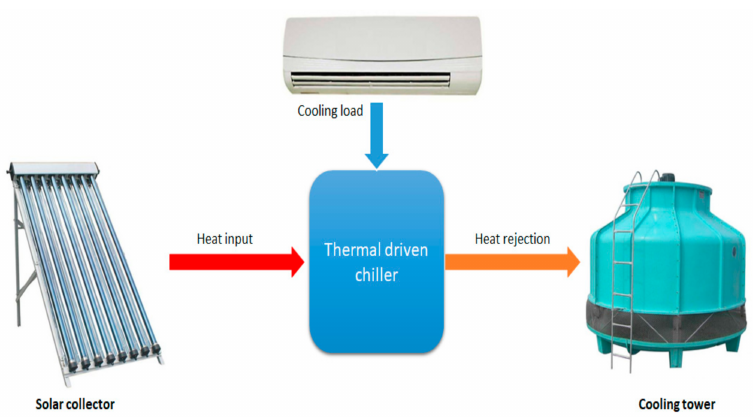
Figure 1. Thermally driven system and its energy flow.